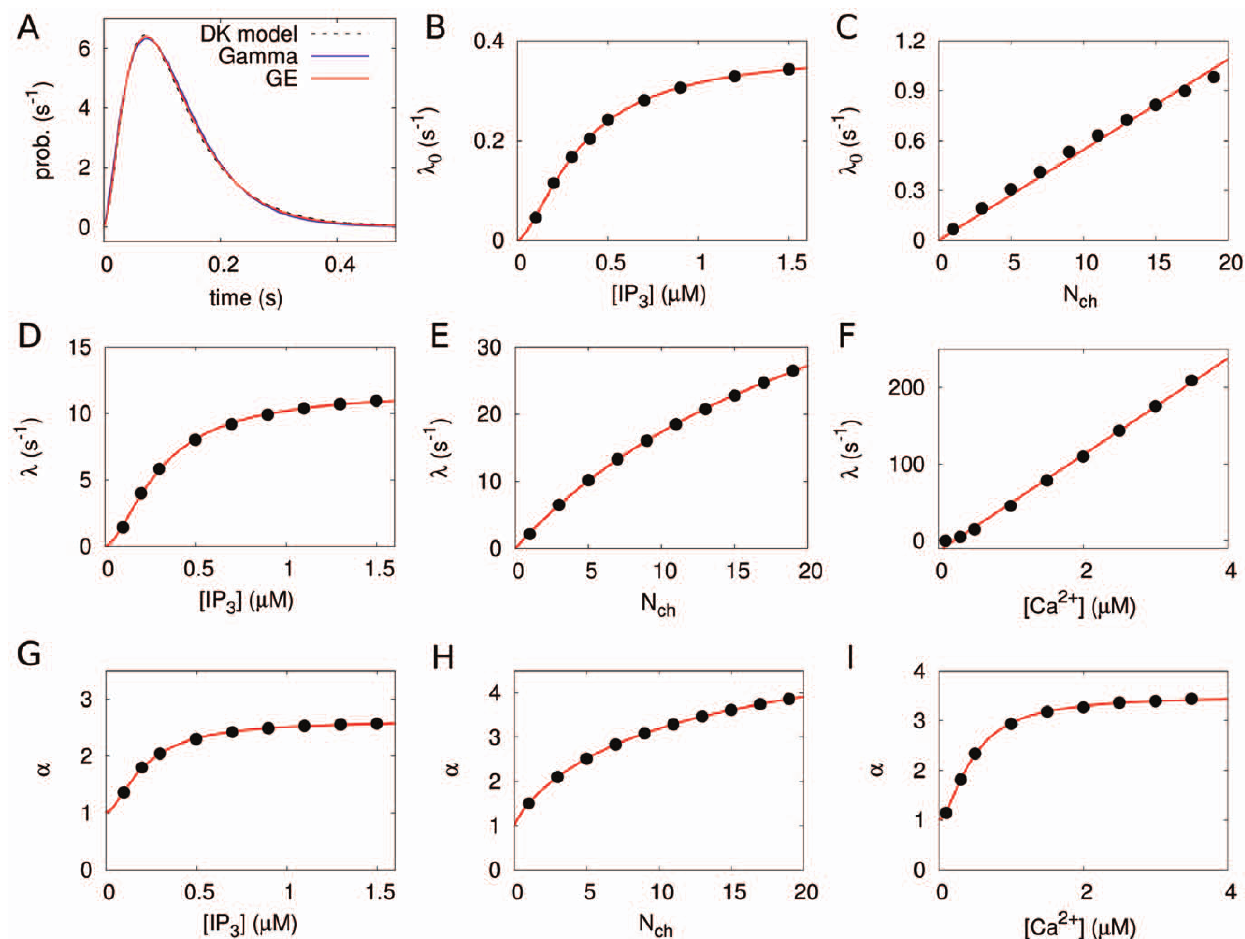
Figure 2. Parameter dependencies of the opening probabilities y o . (A) Comparison of fits of Gamma and GE distributions to the De Young- Keizer model (see Ref. [34] and Table S1) at ½ Ca 2 z (cid:2) =0.6 m M . (B–I) Circles are fits of results from the De Young-Keizer model to GE distributions (Eq. 3) with parameters a and l , as in A. Lines are (B,D,E) nonlinear fits to Eq. 4, (C,F) linear fits, (G–I) nonlinear fits to Eq. 5. (B–C) show the dependencies for the puff-rate, i.e. at base-level ½ Ca 2 z (cid:2) =0.1 m M (see Text S1). (D–H) show parameter dependencies in the regime of a puff, i.e. with one nearby cluster already open, yielding ½ Ca 2 z (cid:2) =0.6 m M (see Text S1). Other parameter values (if not varied on the x-axis) are N ch =5, ½ IP 3 (cid:2) =1 m M .